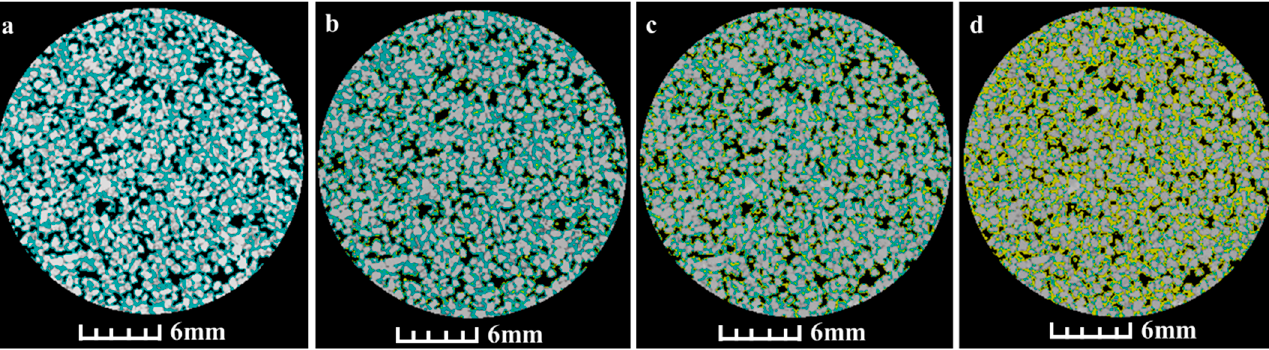
Figure 9. X-CT images of a sample cross-section during hydrate formation, where ( a – d ) represent different formation stages: ( a ) before hydrate formation, ( b ) the initial stage of hydrate formation, ( c ) the middle stage of hydrate formation, and ( d ) the late stage of hydrate formation. The yellow represents methane hydrate, the blue represents NaCl solution, the light gray represents sand, and the black represents methane gas.